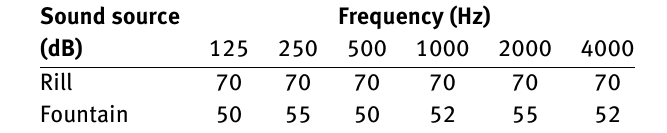
Table 2: Octave band spectra (dB) of the water features sound sources used for simulation